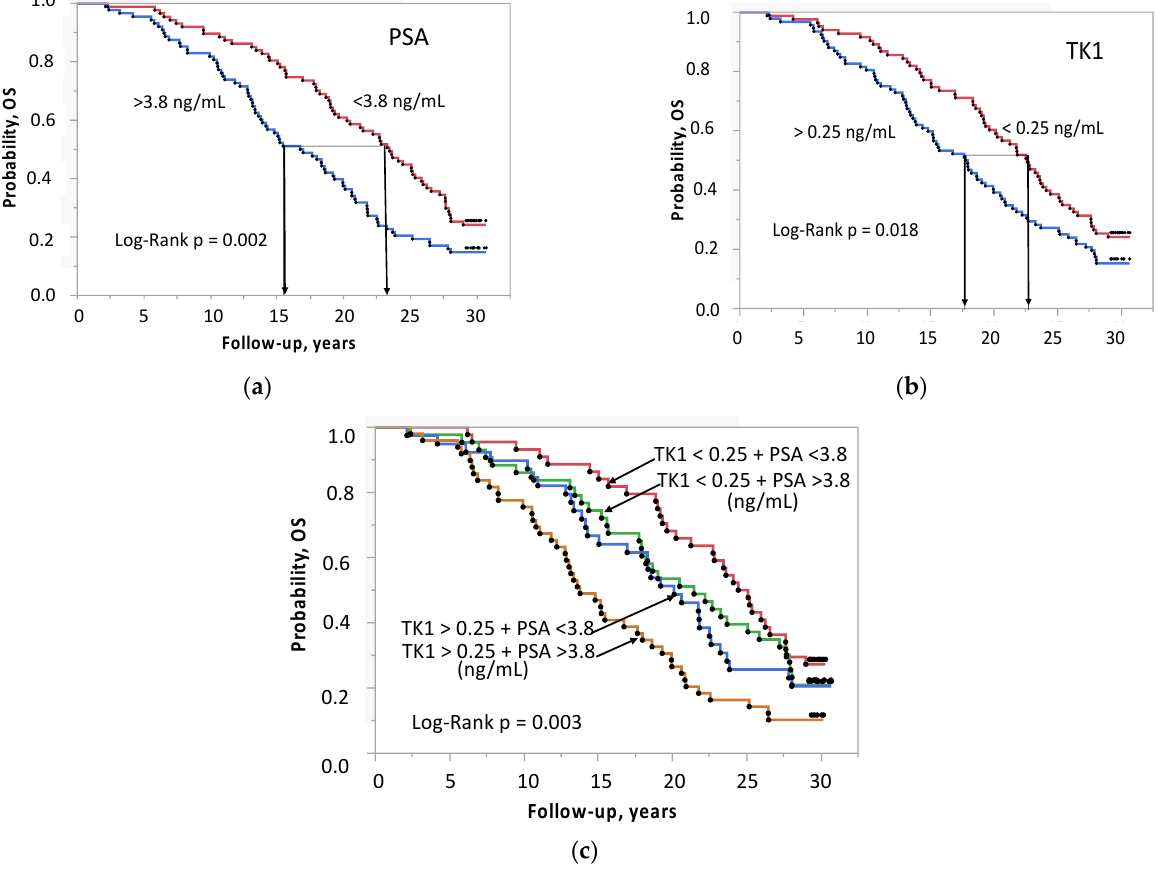
Figure 3. Overall survival by Kaplan–Meier estimates in 175 men with prostate cancer, ( a ) according to the median concentration of PSA ( b ), according to the median concentration of TK1, ( c ) according to TK1 + PSA. 1. TK1 < 0.25 + PSA < 3.8 ng/ml, 2. TK1 < 0.25 + PSA > 3.8 ng/ml, 3. TK1 > 0.25 + PSA < 3.8 ng/ml, 4. TK1 > 0.25 + PSA > 3.8 ng/ml. Abbreviations: PSA = prostate-specific antigen, TK1 = thymidine kinase 1.